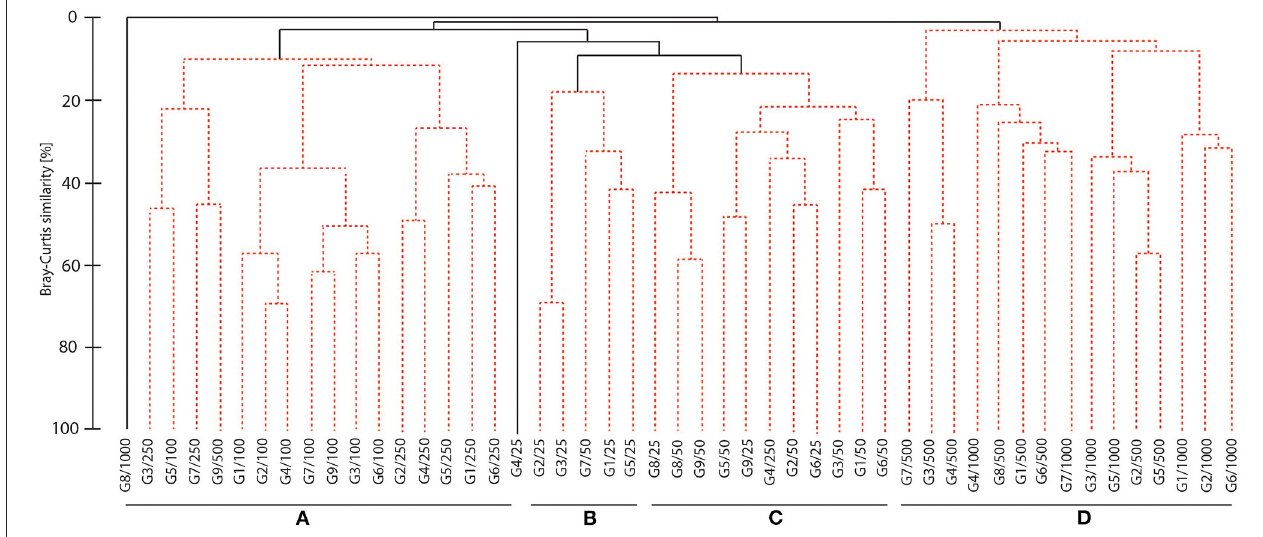
FIGURE 5 | Dendrogram of samples, for Bray Curtis similarity, square root transformed data, and group average grouping method. (Spotted lines indicate the samples that cannot be significantly differentiated by